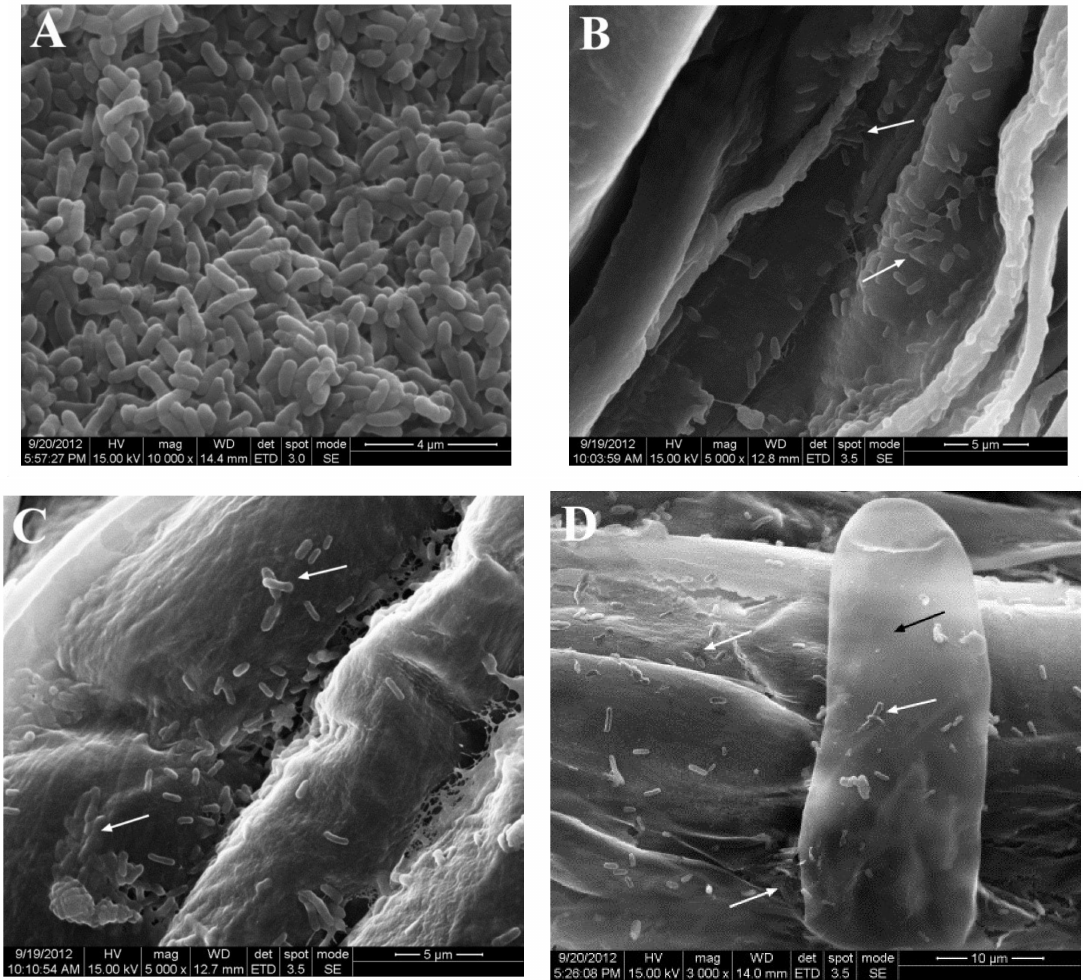
Figure 3. Scanning microscopy images of R. aquatilis JZ-GX1 colonizing corn roots in a gnotobiotic system. ( A ). Bacterial cells of JZ-GX1. ( B , C ). JZ-GX1 cells on the concave parts of root surfaces. ( D ). JZ-GX1 cells on a root hair and the surrounding epidermis. The white arrows indicate the JZ-GX1 cells in all panels. The black arrow points to the root hair in